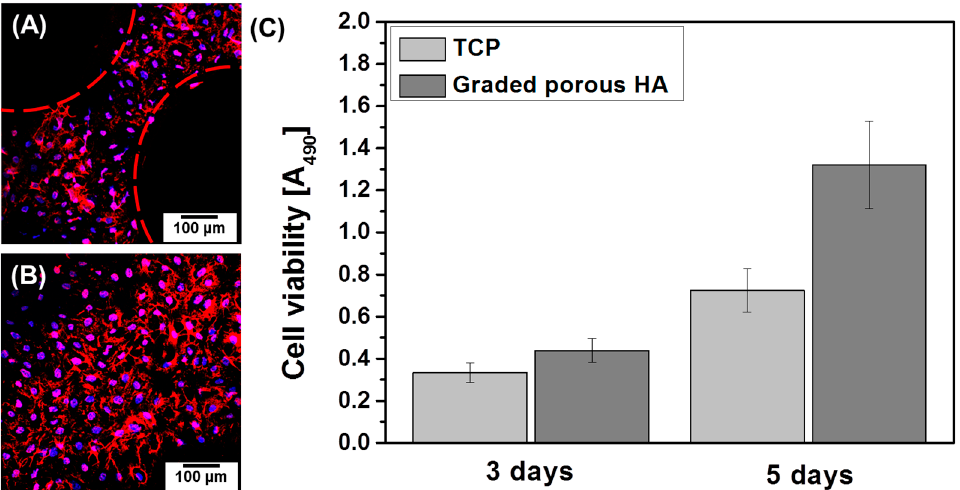
Figure 10. CLSM images of preosteoblast cells cultured for 5 h on porous HA scaffolds with bone-like structures: ( A ) porous part and ( B ) dense part; ( C ) Cell viabilities of the preosteoblast cells cultured for three and five days on porous HA scaffolds with bone-like structures.